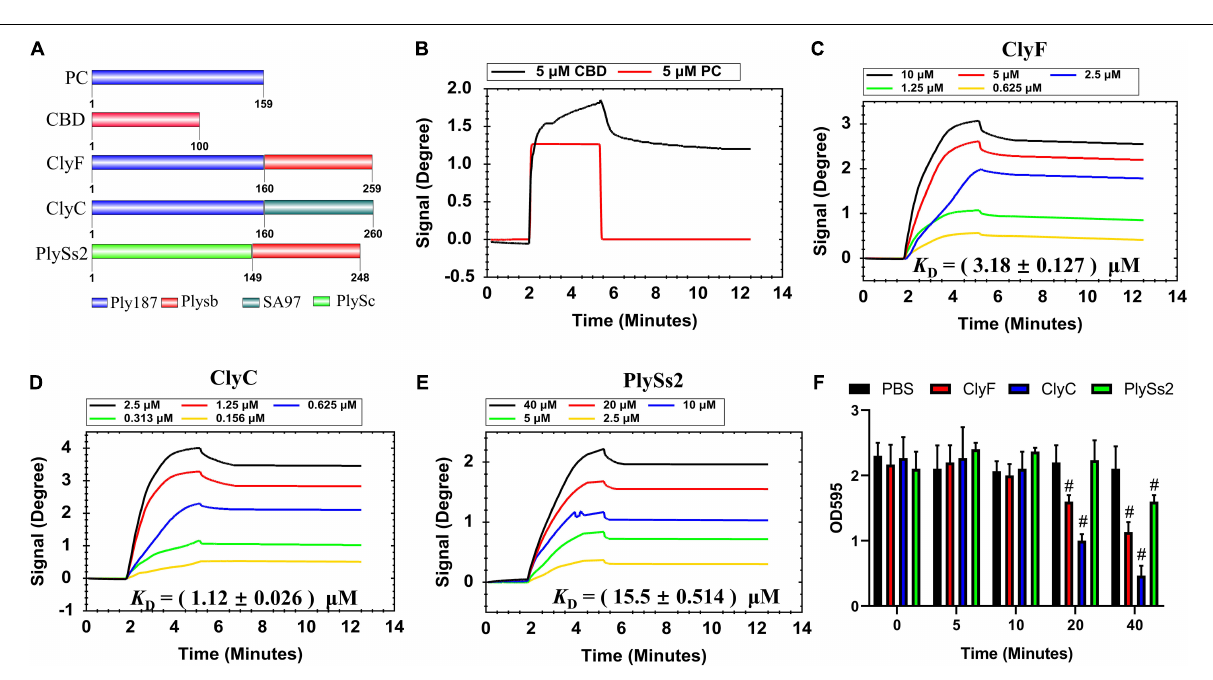
FIGURE 4 | Determination of lysin binding affinity to S. aureus biofilm. (A) Schematic representation of lysins and their constituents. Sensorgrams depicting (B) CBD and PC; (C) ClyF; (D) ClyC; and (E) PlySs2 dose-dependent binding to culture-on-chip S. aureus biofilm. (F) Biofilm removal efficacy of 2.5 µ M lysin (ClyC, ClyF, PlySs2) and PBS over time. # denotes p <